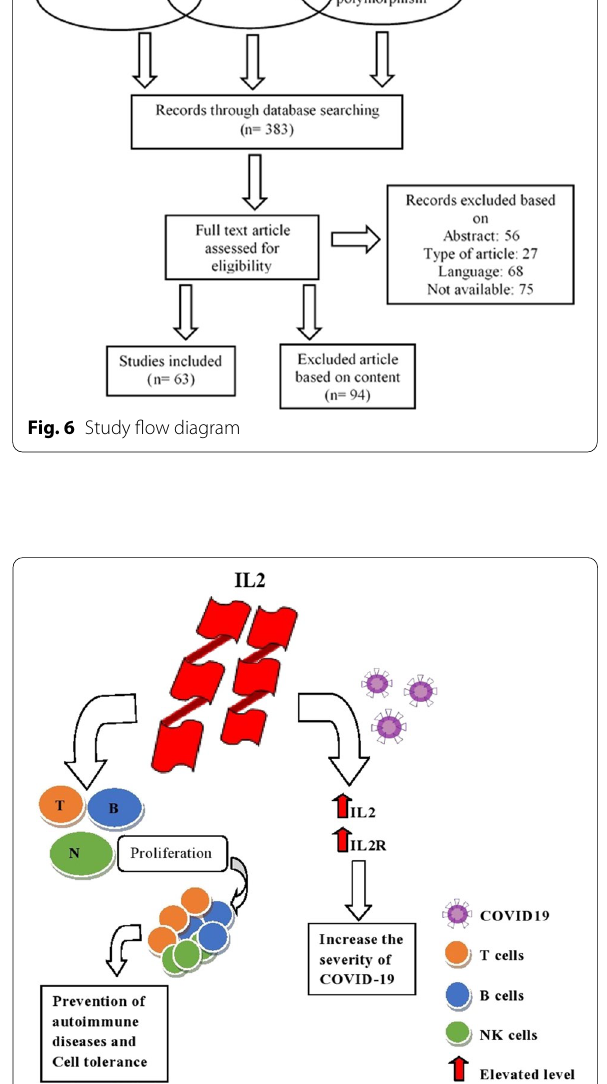
Fig. 7 The severity of SARS-CoV-2 due to the interleukin-2 cytokine